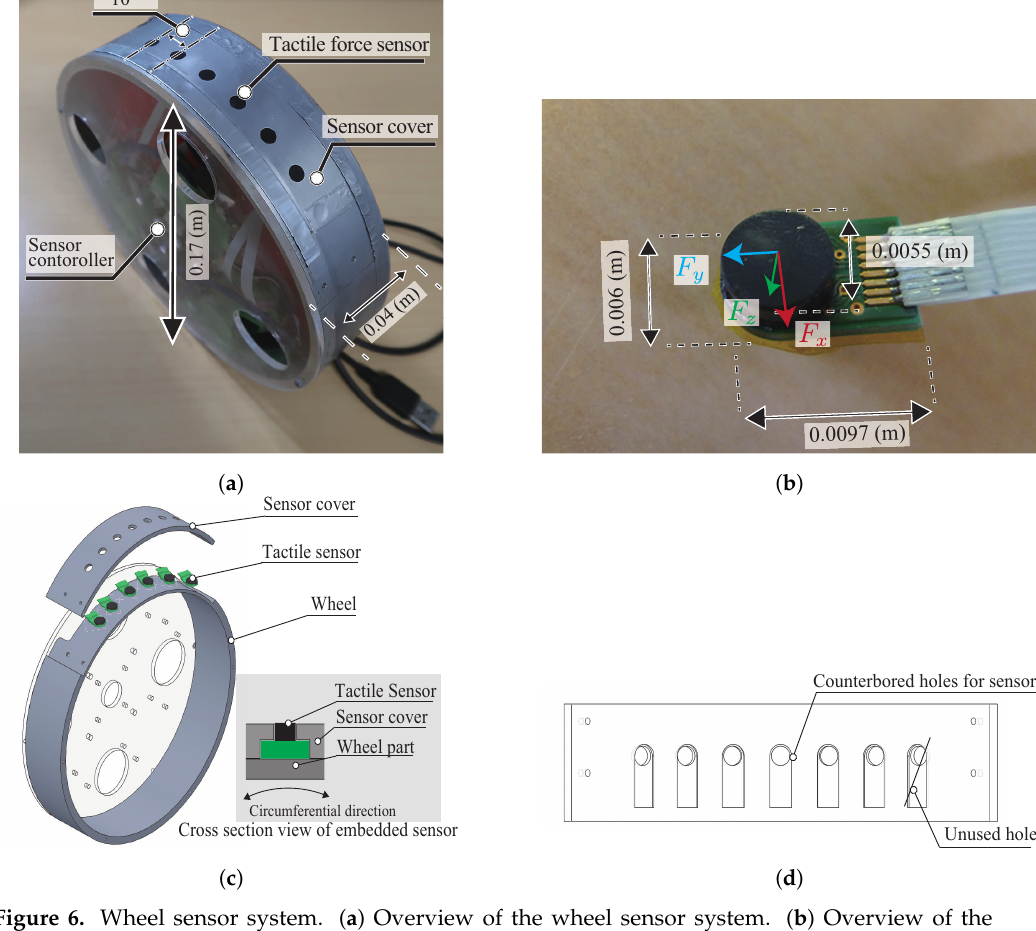
Figure 6. Wheel sensor system. ( a ) Overview of the wheel sensor system. ( b ) Overview of the tactile force sensor. ( c ) Installation of the tactile force sensors on the wheel ( d ) Schematic view of the sensor